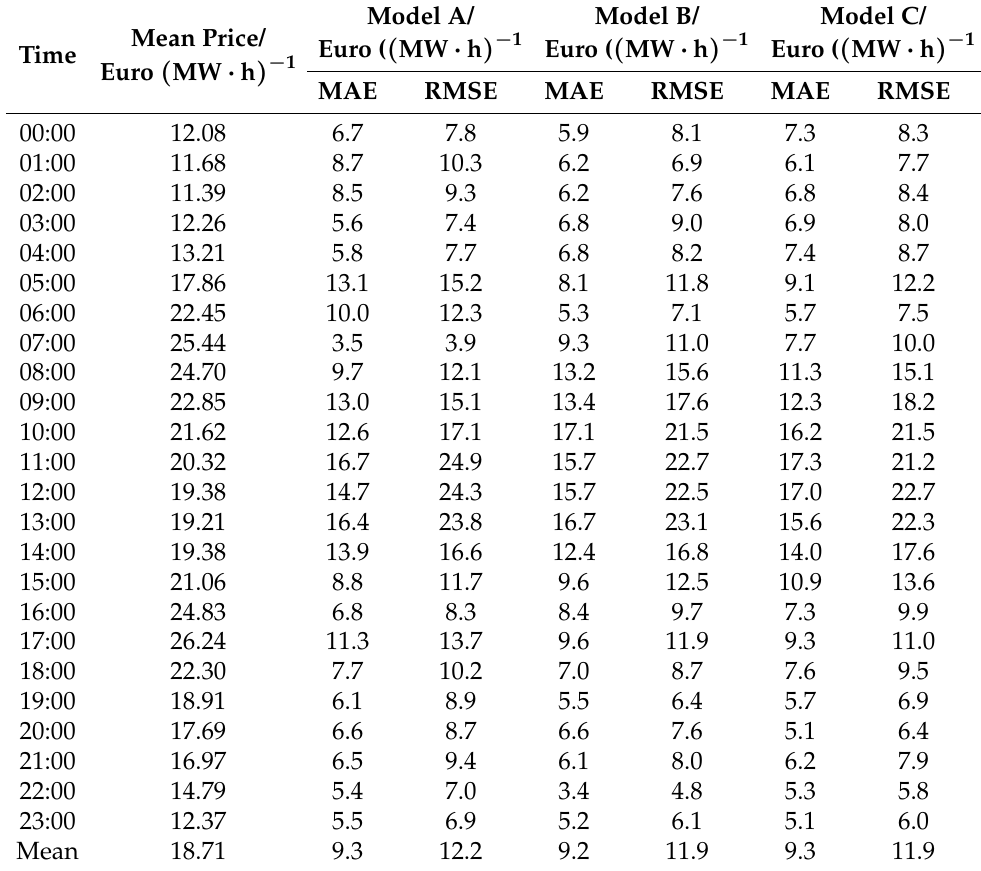
Table 2. Comparison of model prediction errors.